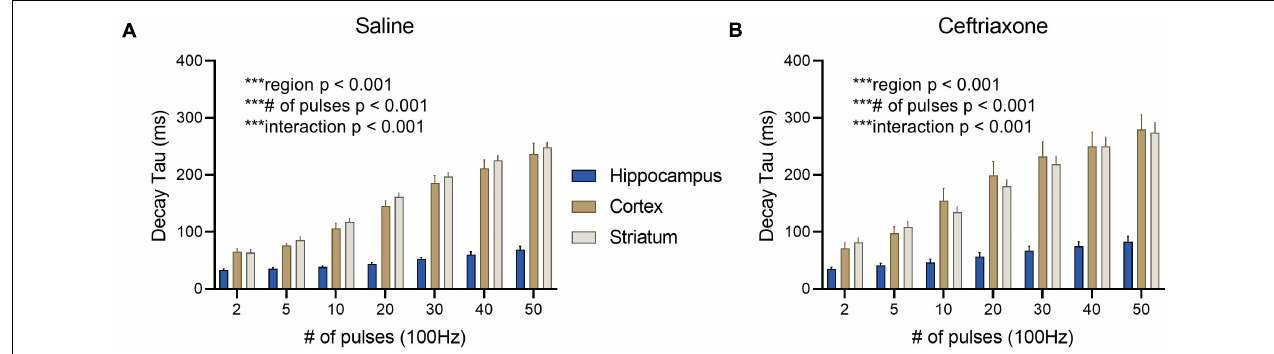
FIGURE 4 | The effect of ceftriaxone on regional differences in glutamate clearance. (A) Mean ( ± S.E.M) iGluSnFR decay tau values to compare regional differences in glutamate clearance in saline-treated mice. (B) Mean ( ± S.E.M) iGluSnFR decay tau values to compare regional differences in glutamate clearance in ceftriaxone-treated mice. *** p <